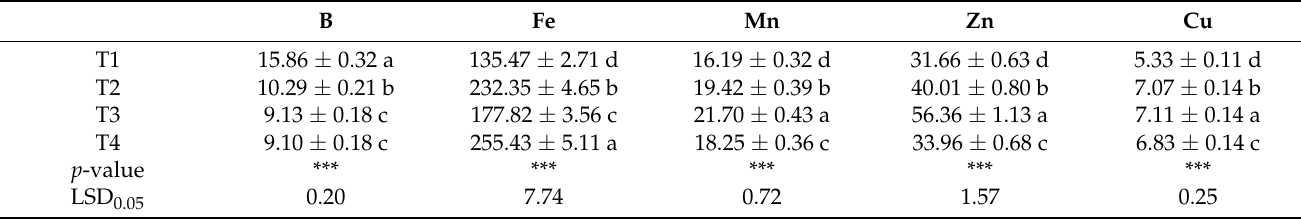
Values are means ± standard deviation ( n = 9). Values with different letters indicate significant differences among treatments. The level of significance was represented as p < 0.001